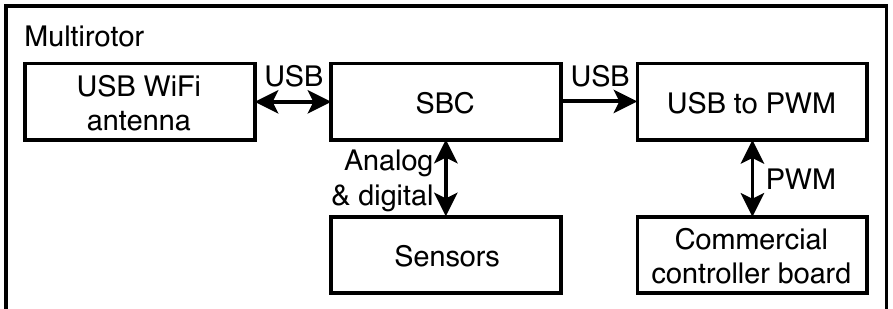
Figure 1. Diagram showing the connections on